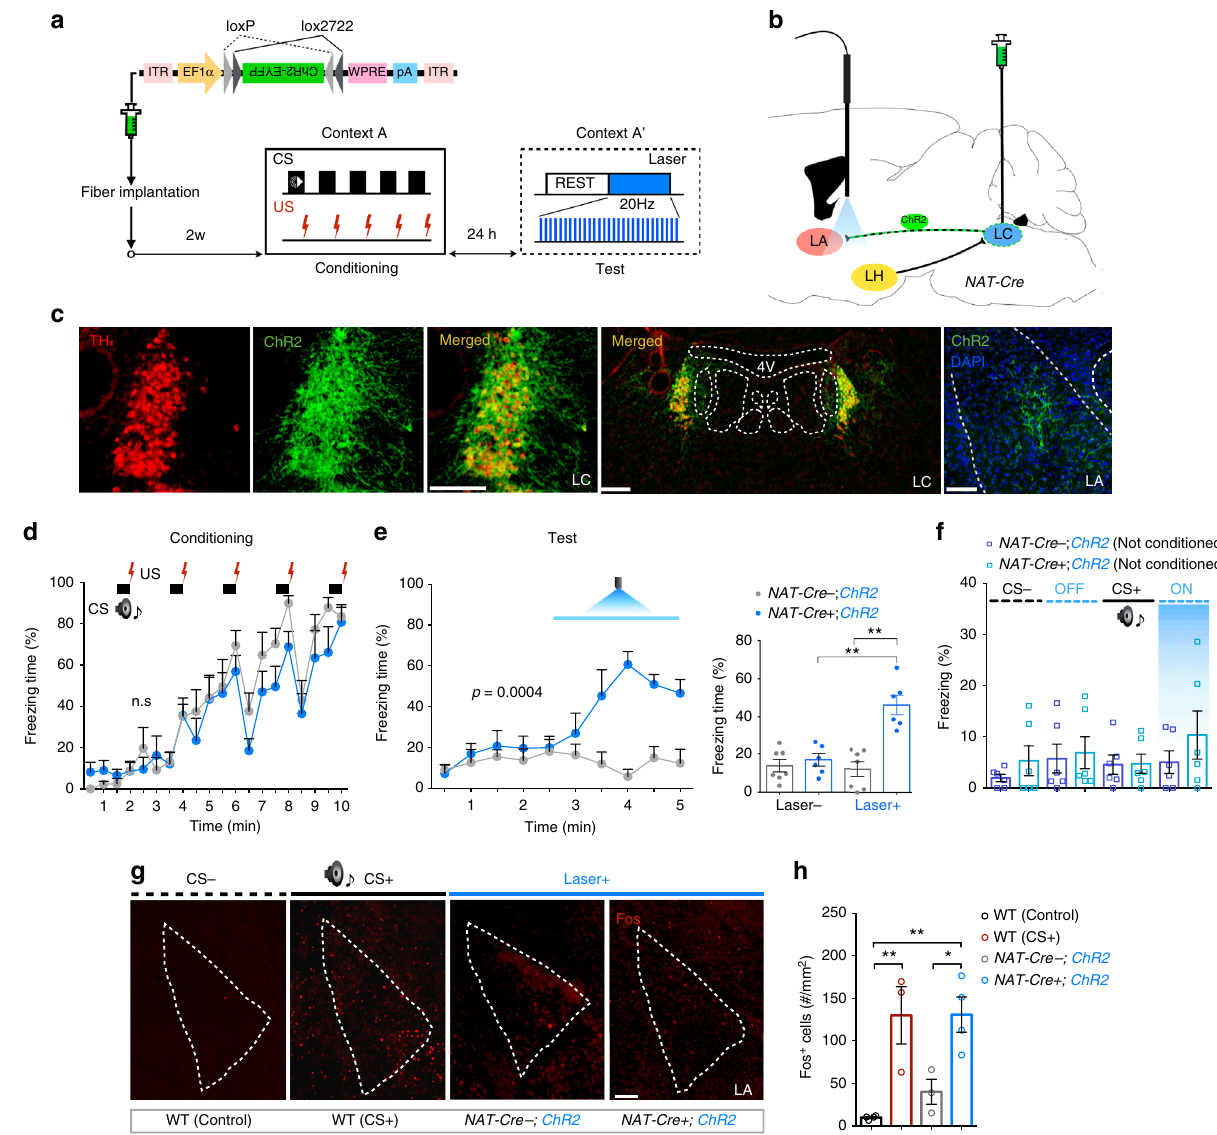
Fig. 6 Optogenetic stimulation of NA LC → LA -induced freezing behavior in Context A ′ . a Experimental procedure. b Schematic representation showing sites of AAV 10 -FLEX-ChR2-EYFP delivery and optic fi ber implantation. c Focal expression of Cre-dependent ChR2 in NA LC neurons and their axonal terminals in the LA. Scale bars: left, 100 μ m; center, 200 μ m; right, 200 μ m. d , e After cued fear conditioning, optogenetic stimulation of NA fi bers in the LA for 150 s was applied in an altered context (A ′ ). A signi fi cant increase in freezing time was induced by laser stimulation without applying auditory CS. f Control experiment shows that an increased freezing response induced by laser stimulation was not observed in mice without prior fear conditioning. g , h Optogenetic stimulation of NA LC → LA fi bers induced robust Fos expression in the LA, to the same degree as that in WT with CS. Scale bars: upper panel, 100 μ m. * p < 0.05, ** p < 0.01. Values are mean ±